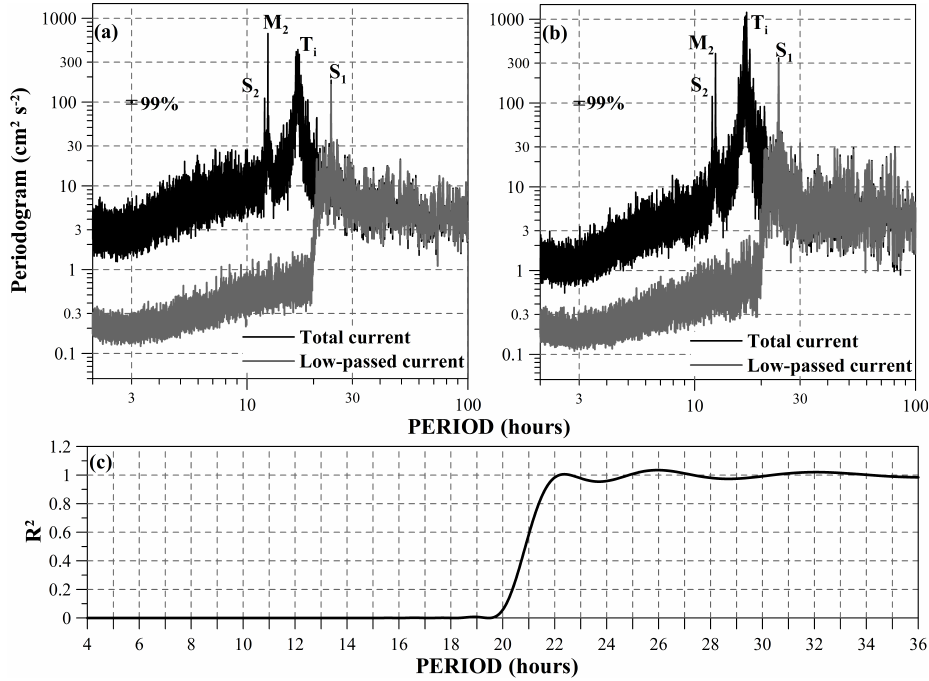
Fig. 2. Averaged Lomb–Scargle periodograms (99% confidence level) for (a) zonal and (b) meridional HF radar currents for the period 2009–2010. Spectra were computed on total and low-pass filtered currents. (c) Response factor ( R) of the low-pass filter (with a cut-off of 20h and 137 points). Note: S 2 is semidiurnal principal solar gravitational tide, M 2 is semidiurnal principal lunar gravitational tide, T i is inertial period and S 1 is wind-induced (breezes) diurnal